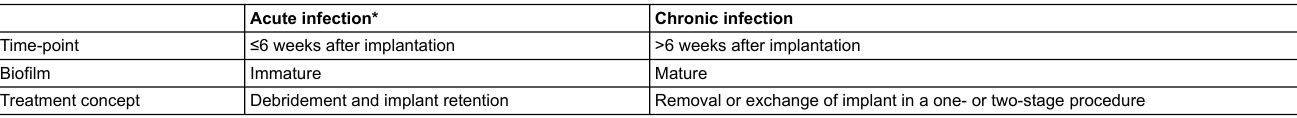
Table 1: Classification of implant-associated infections according to the time of occurrence. Acute infection* Chronic